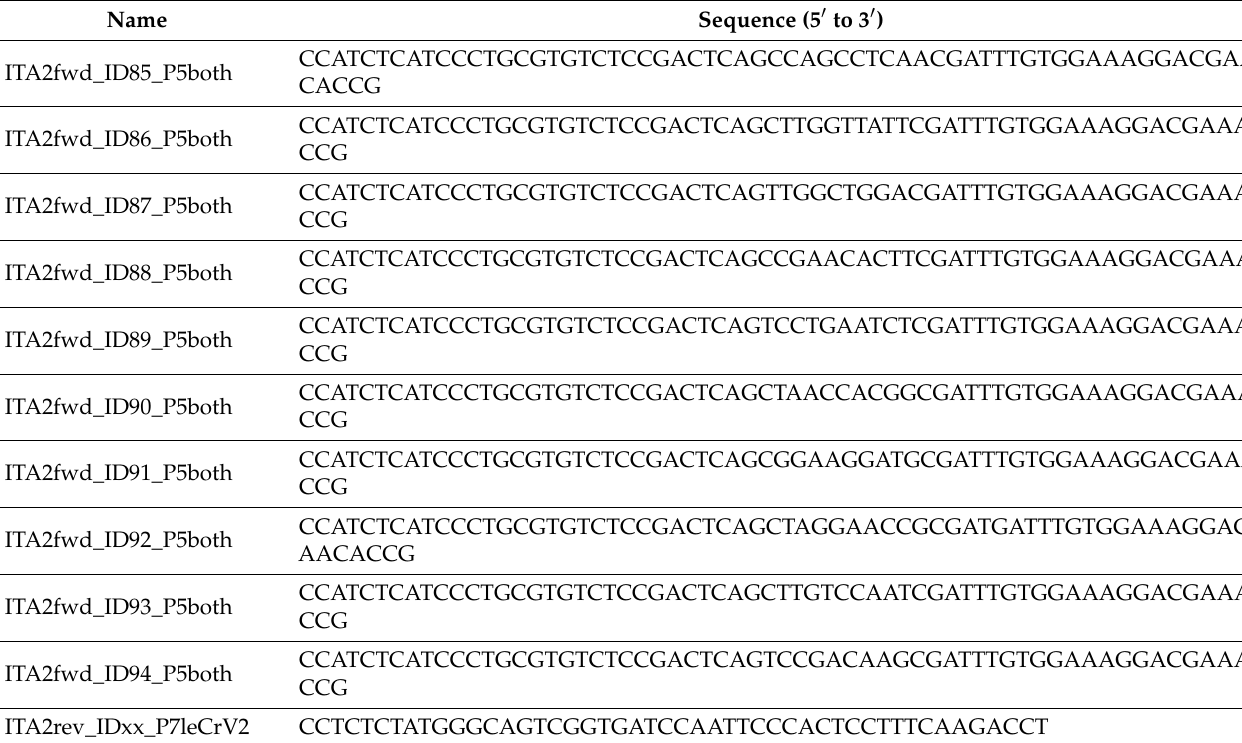
Table 2. Oligonucleotide sequences for IonTorrent